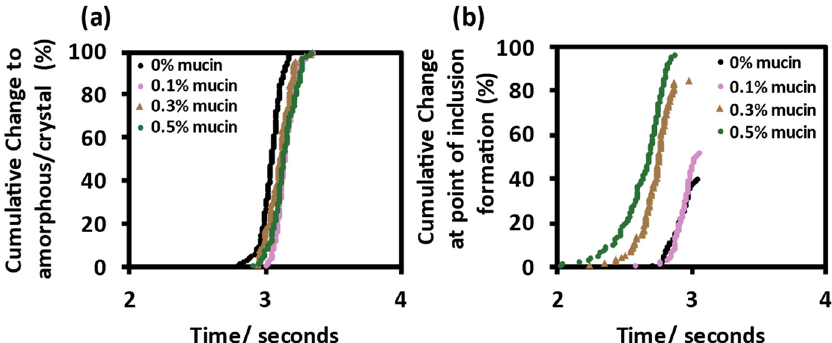
Figure 6. Change in morphology of evaporating droplets. Phase change analysis of evaporating droplets, time resolution of 10 ms, N = 100 (DMEM, 10% FBS and % w / v mucin). Cumulative change in morphology to ( a ) amorphous/crystal and ( b ) inclusions.